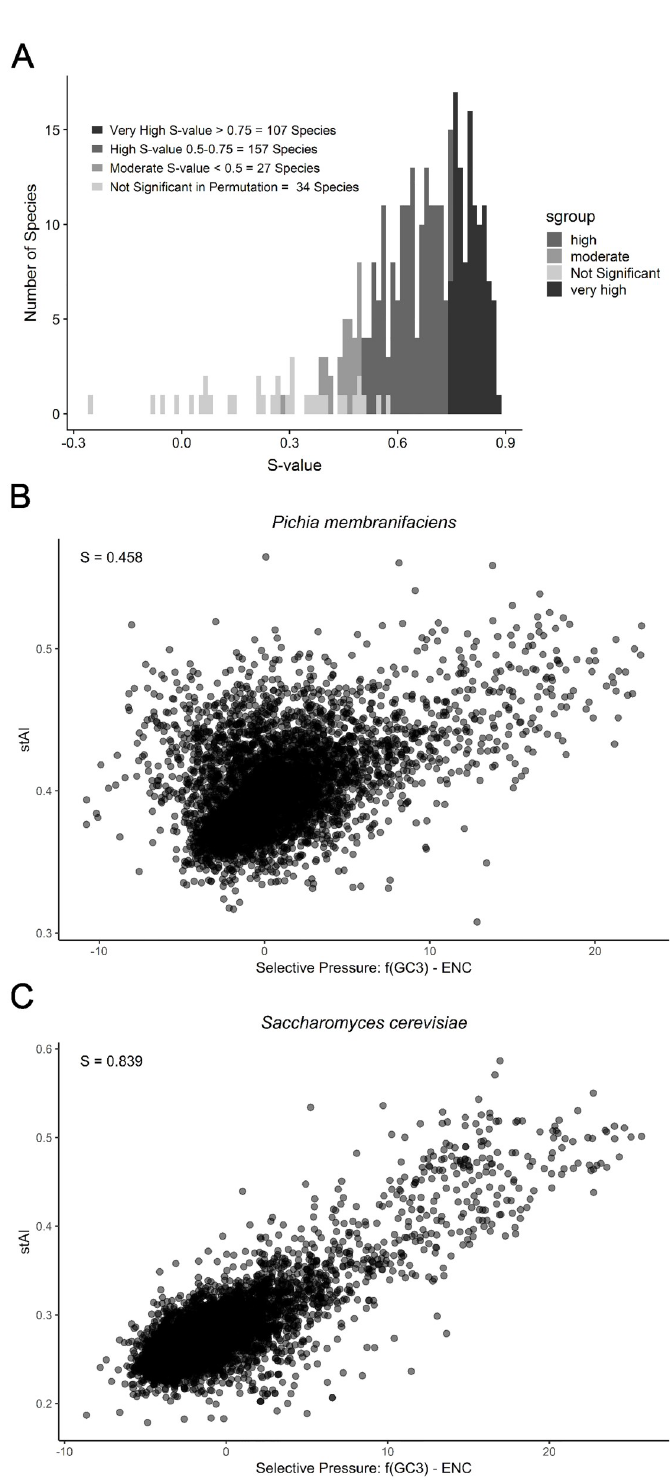
Fig 6. Most genomes in the budding yeast subphylum exhibit moderate to high levels of translational selection on codon bias. Translational selection on codon bias was measured using the S-test, which examines the correlation between the stAI value and the selective pressure (estimated by f(GC3)-ENC where f(GC3) is a modified function of Wright’s neutral relationship between the silent GC content of a gene and the effective number of codons) on all coding sequences in a genome. Each point in the comparison between stAI and selective pressure is a single